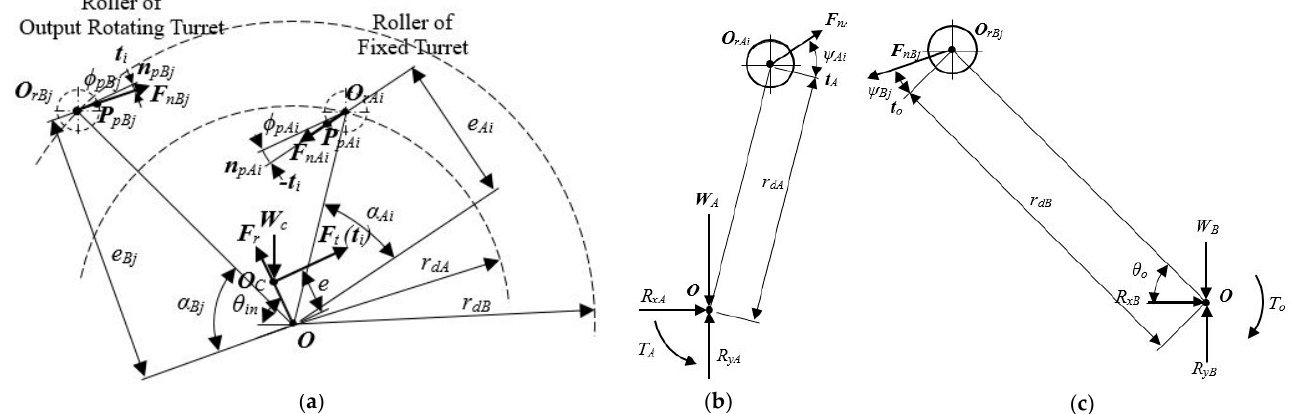
Figure 4. Analysis of forces and torques of turrets: ( a ) the conjugate rigid lobe cam; ( b ) the fixed turret; ( c ) the rotating output turret.